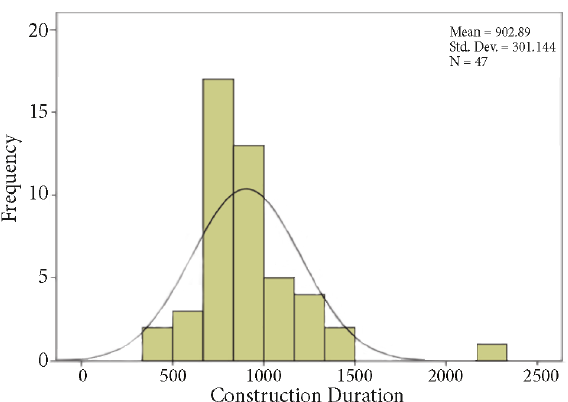
Figure 3. Distribution status of the performance data per construction